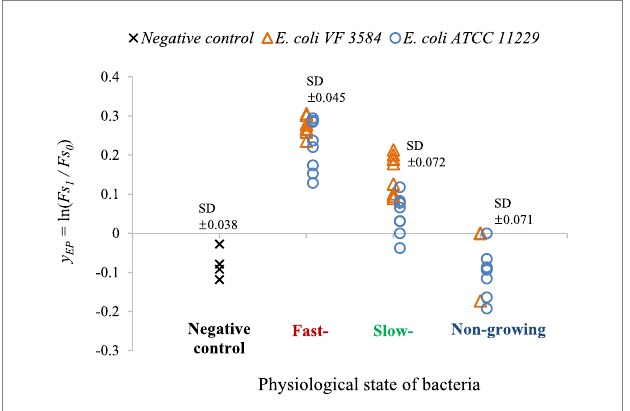
FIGURE 8 y EP values of non-treated cultures to describe the efflux activity as a function of the physiological state of the cells. Untreated cultures of E. coli VF 3584 (orange markers) and E. coli ATCC 11229 (blue markers) were tested for fast-, slow- and non-growing phases. As a negative control the y EP measured in PBS are also shown (black markers).